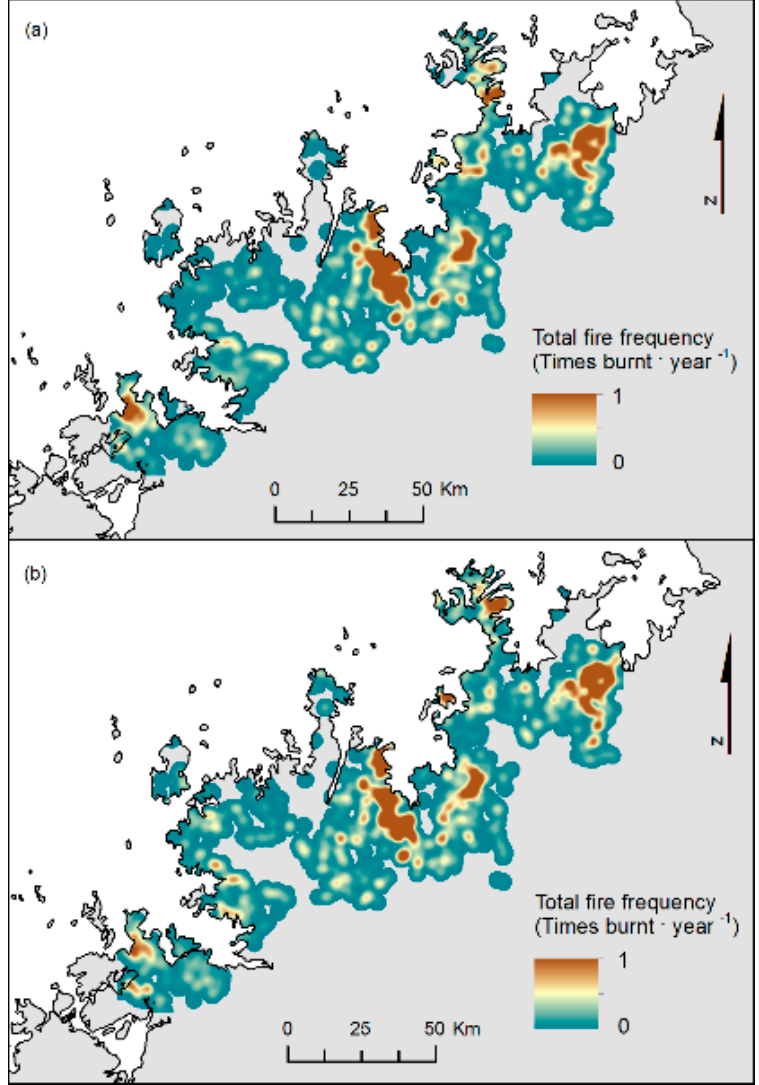
Figure 5. Heat maps showing total fire frequency in proximity of rainforests during ( a ) the unmanaged baseline years and ( b ) the project years.